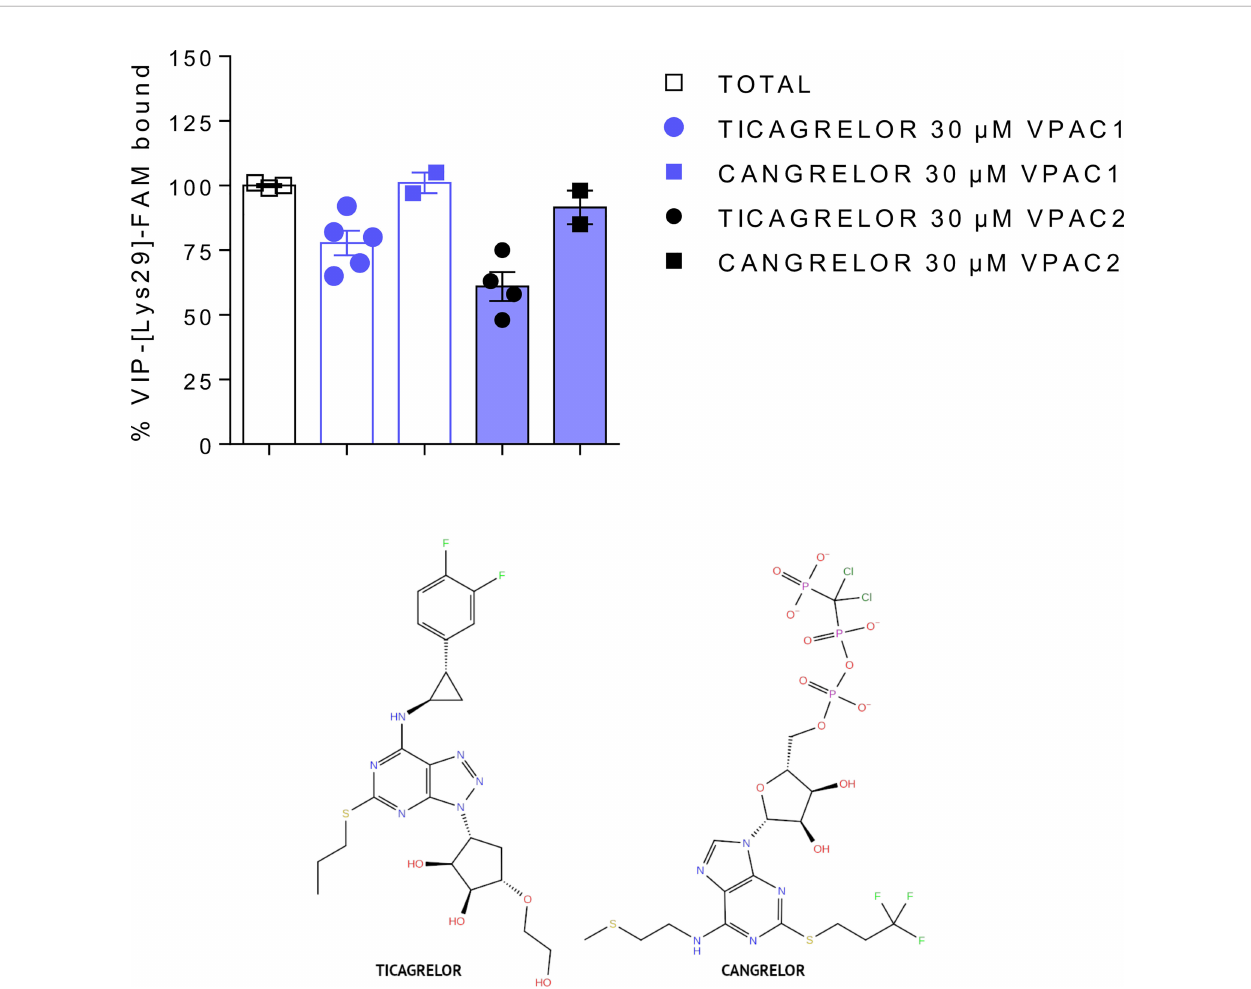
FIGURE 2 | Comparison of the effect of ticagrelor and cangrelor in VIP competition binding assays (top panel). Ticagrelor (closed circles) reduced VIP binding to VPAC1 and VPAC2, while cangrelor (closed squares) had no signi fi cant effect. Both compounds share similar scaffolds (bottom panel).